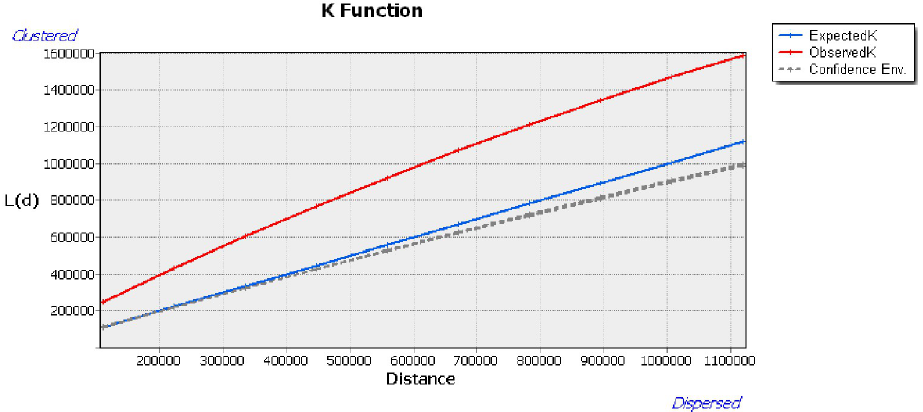
Fig 1. Results of Ripley K(r) function for beautiful leisure